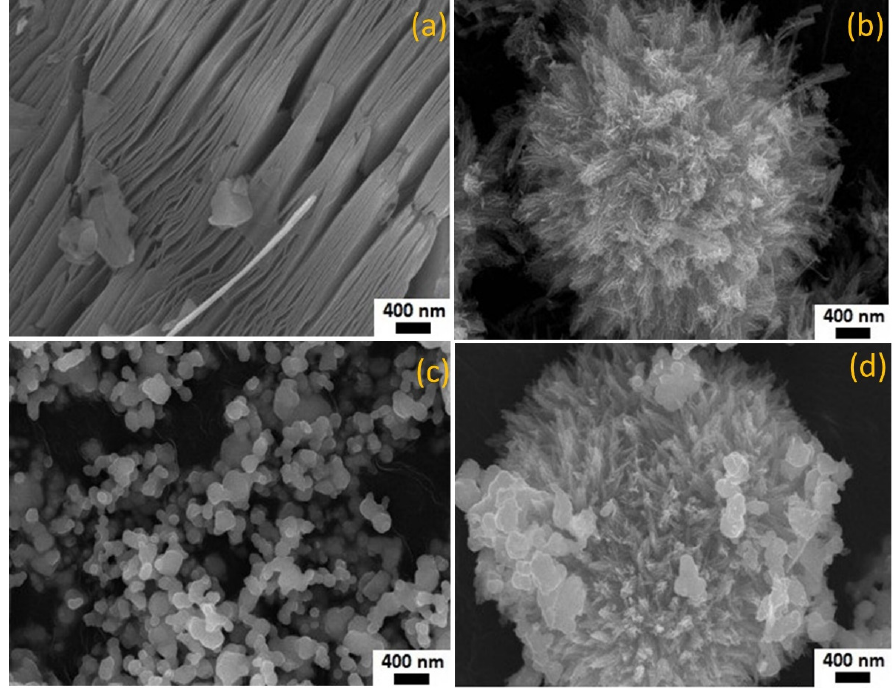
Figure 2. SEM images of ( a ) Ti 3 C 2 , ( b ) TiO 2 @Ti 3 C 2 , ( c ) Ag 3 PO 4 , and ( d ) Ag 3 PO 4 /TiO 2 @Ti 3 C 2 (A4) samples.